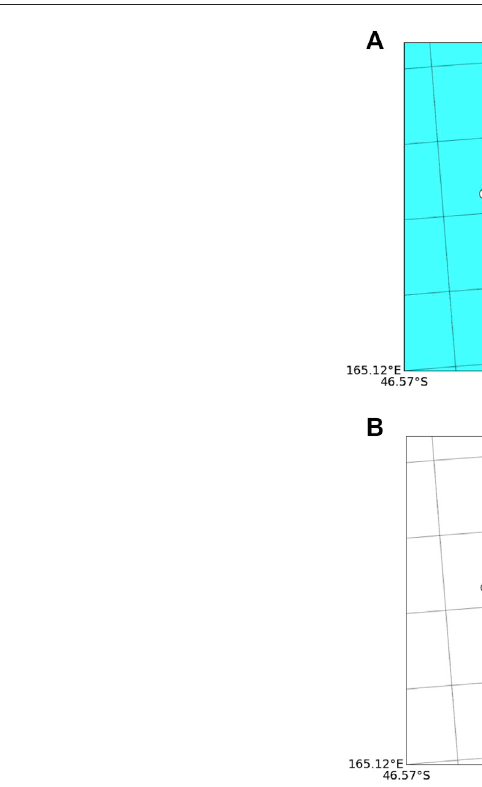
In Figure 4 , we exemplify this search for an optimal d th. Blue bars indicate the percentage of events with at least one solution with Φ < 30 ° . The red triangles depict the percentage of events in the dataset considered in the analysis, i.e., events with at least one neighbor inside the sphere ( Ω 1 ). For all regions, as the neighborhood size increases, the percentage of spheres with at least one neighbor increases until an in fl ection point, beyond which it remains constant. We consider this in fl ection point as the threshold size d th. This indicates that, although the neighborhood size increases (and thus the number neighbors), the similarities between FM solutions are not further improved.